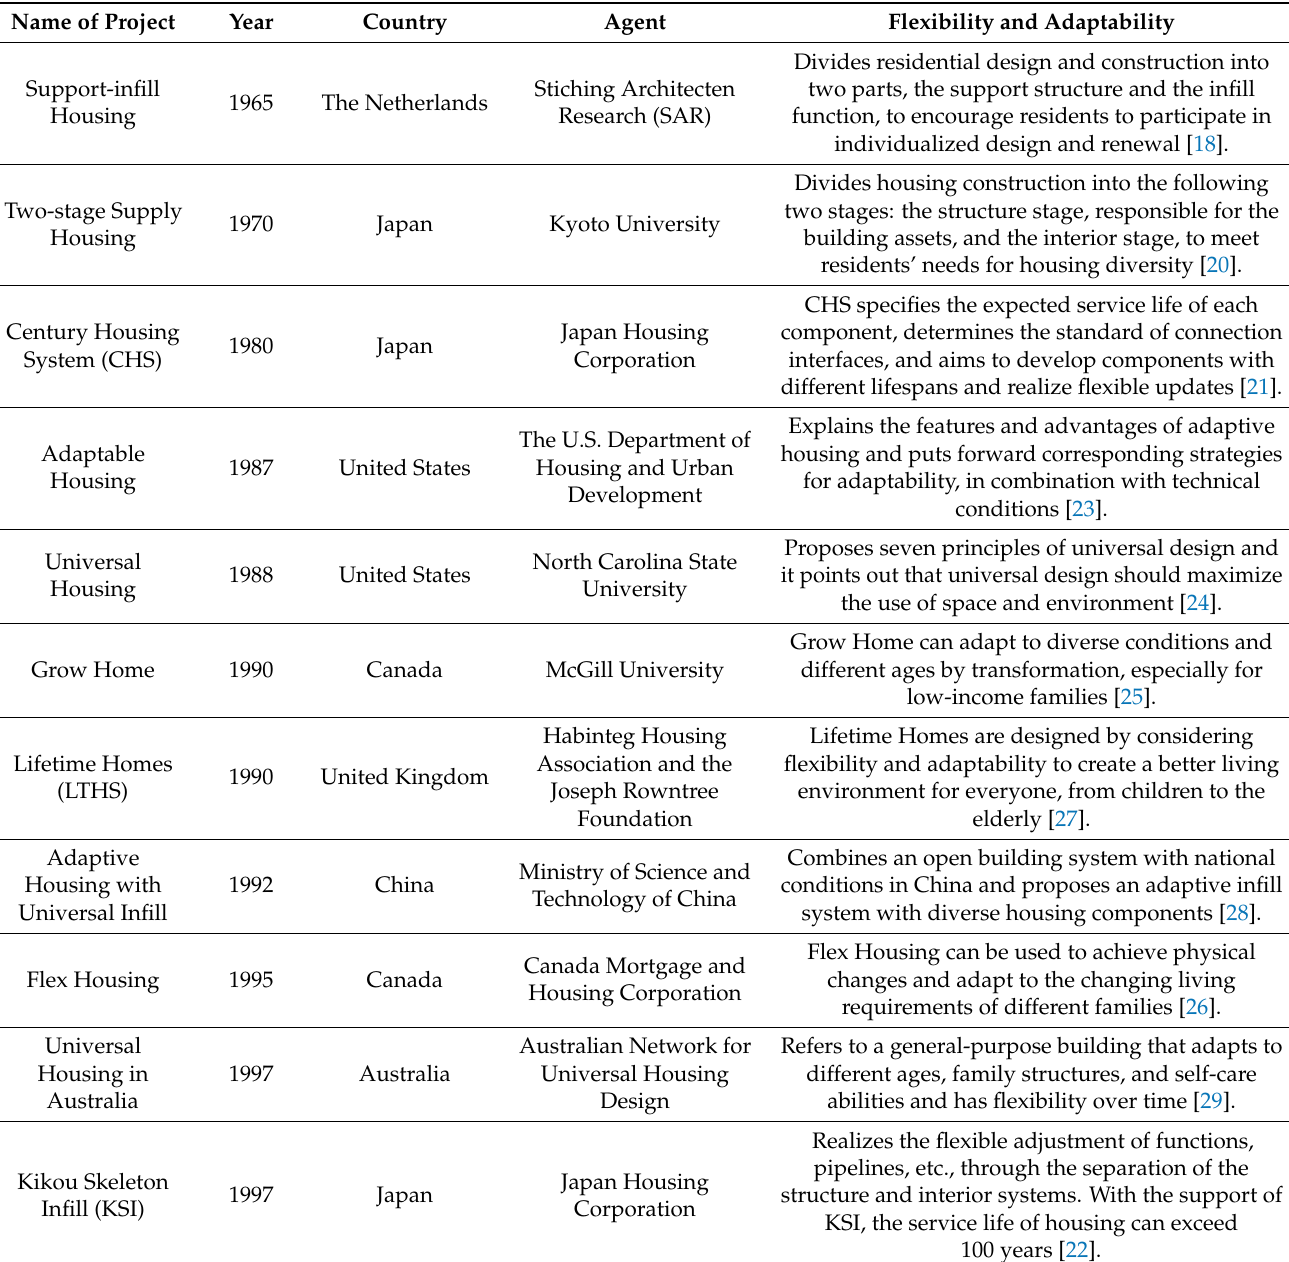
Table 1. Projects on housing flexibility and adaptability in selected